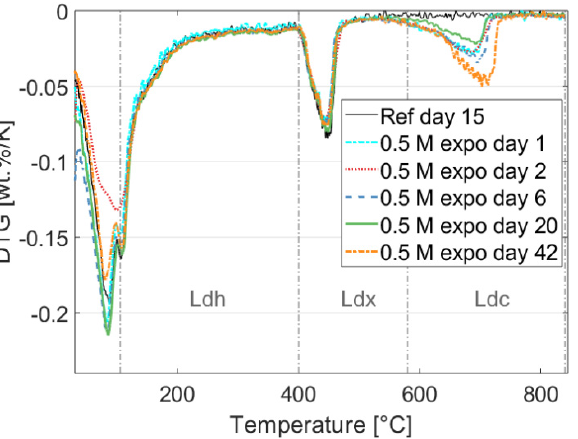
Figure 1. Experimental results showing the effect of exposure on the hydrated phase assemblage of the cement measured by TGA on the reference specimen and during the exposure at 1, 2, 6, 20, and 42 days. The figure shows the temperature ranges for the different decomposition regions of the C-S-H gel (Ldh), Calcium Hydroxide (Ldx), and Carbonate phases (Ldc) (used to estimate the degree of hydration using the method proposed in [49]).